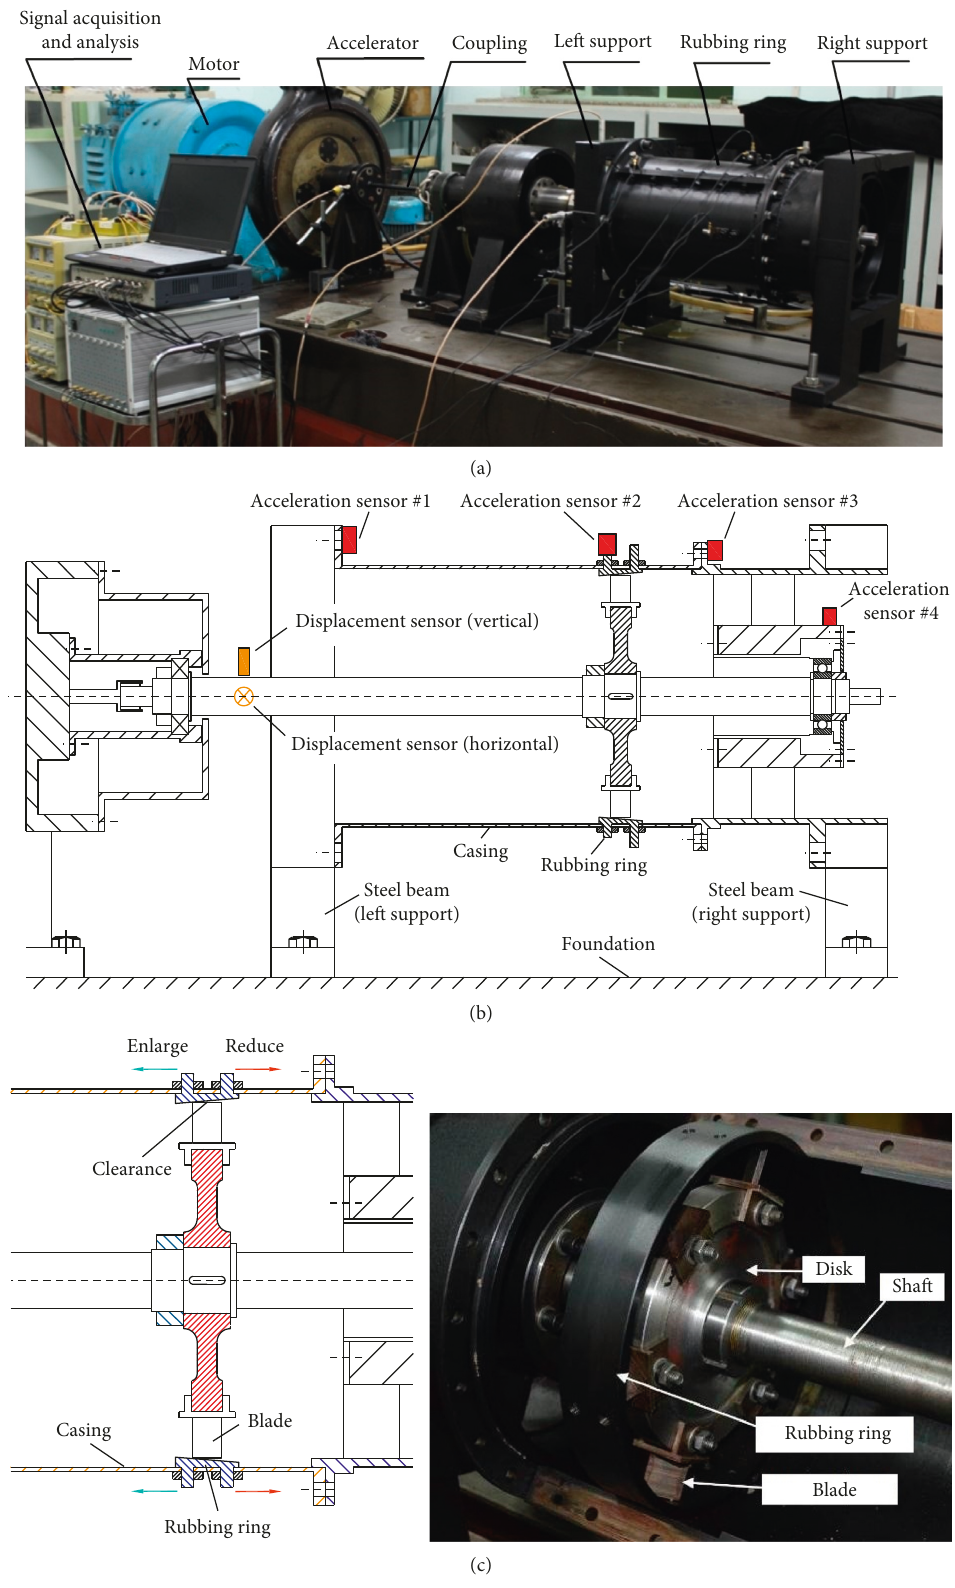
Figure 3: Test rig of rub-impact. (a) The rotor-support-casing test rig. (b) Sensor location and constraints of casing. (c) View of the rotor and the rubbing